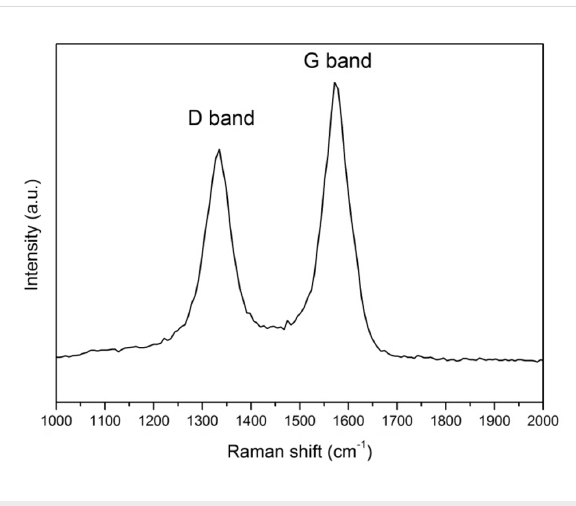
Figure 4: Typical Raman spectrum of VA-CNT